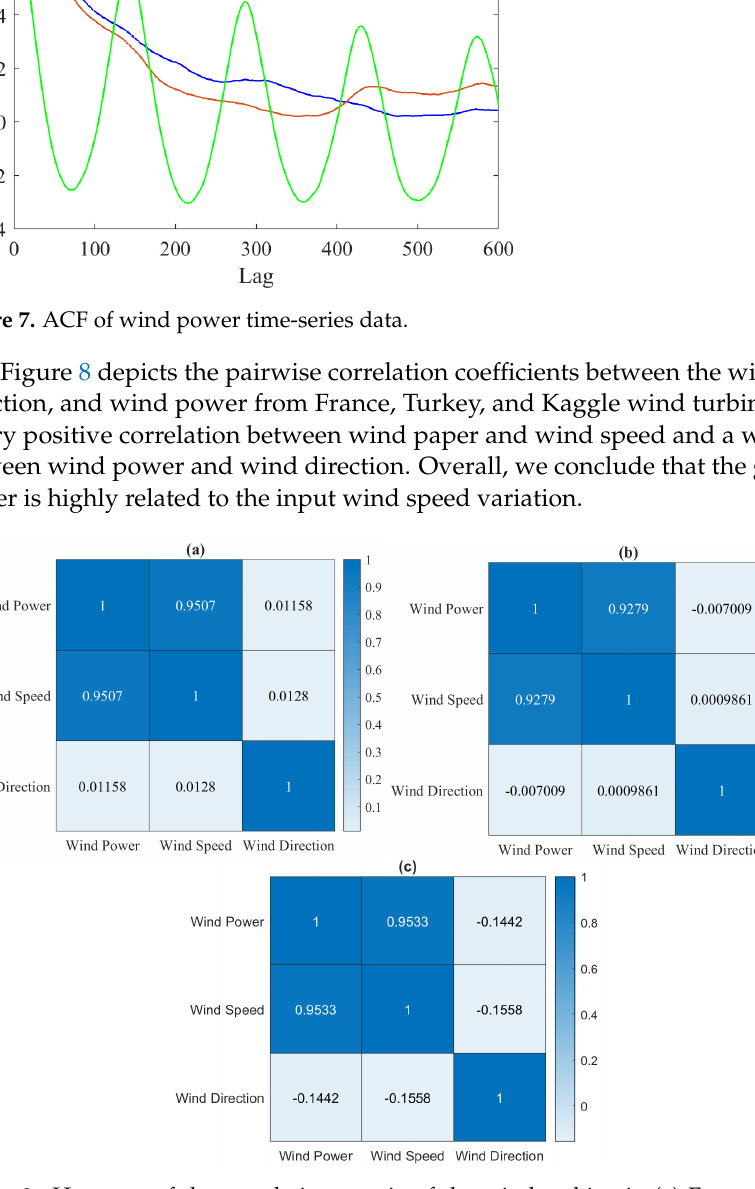
Figure 8. Heatmap of the correlation matrix of the wind turbine in ( a ) France, ( b ) Turkey, and ( c )